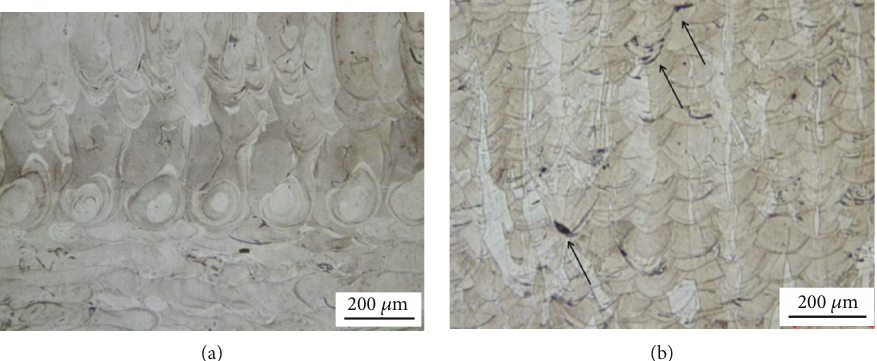
Figure 18: (a) Characteristic optical micrographs of the X-Y plane and (b) of the Y-Z plane of the pool boundaries in sample